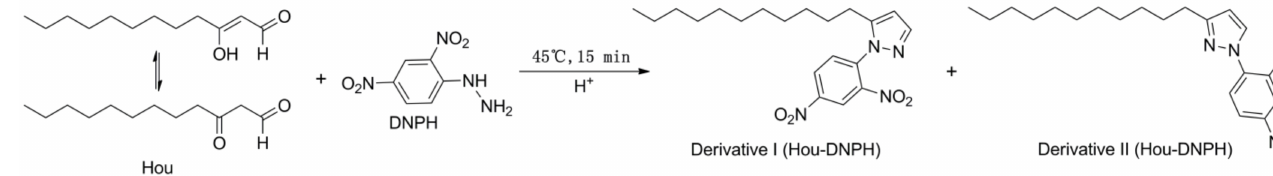
Figure 5. The equation of the Hou and 2,4-dinitrophenyl hydrazine (DNPH)